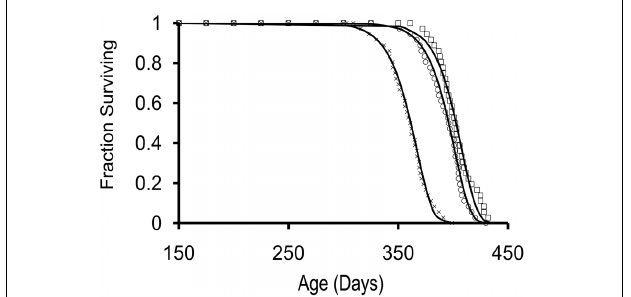
FIGURE 1 | Survivorship curves for 3 cohorts of hatchery-reared Aplysia californica with lifespans of approximately 1 year. Survivorship curves were fit to a Gompertz survival function, s = exp [(A/G) (1-e Gt )], indicated with squares, crosses, and circles for cohort 1, 2, and 3, respectively; starting n = 36 for each cohort.